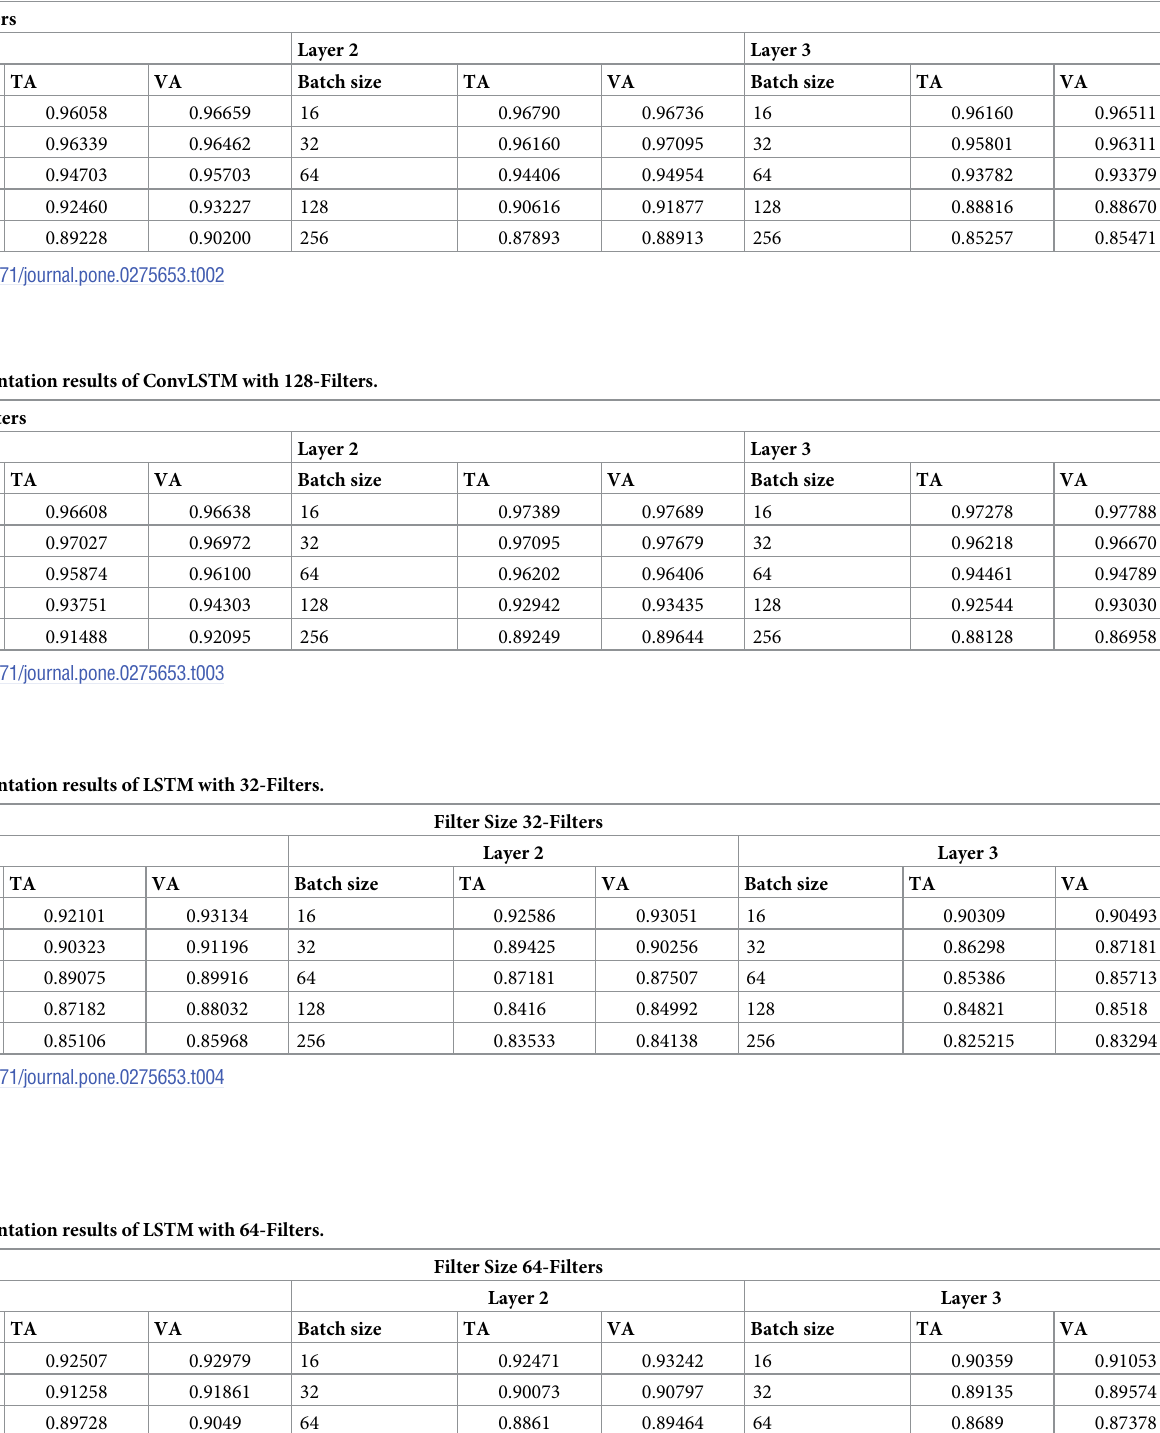
Table 2. Experimentation results of ConvLSTM with 64-Filters.